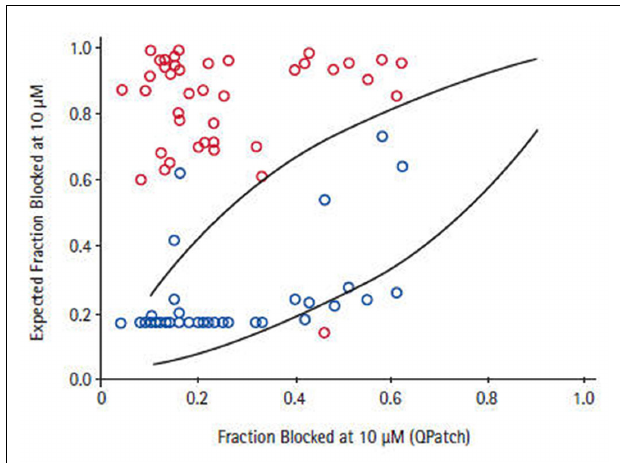
FIGURE 7 | Correlation between QPatch and high-throughput hERG assays. For a subset of compounds for which two high-throughput hERG assays, thallium flux (blue symbol), and 35 S-MK499 binding (red symbol) showed > 7-fold difference in potency, the estimated fraction of block in QPatch hERG recordings correlates to a greater degree with the thallium flux data Schmalhofer et al.